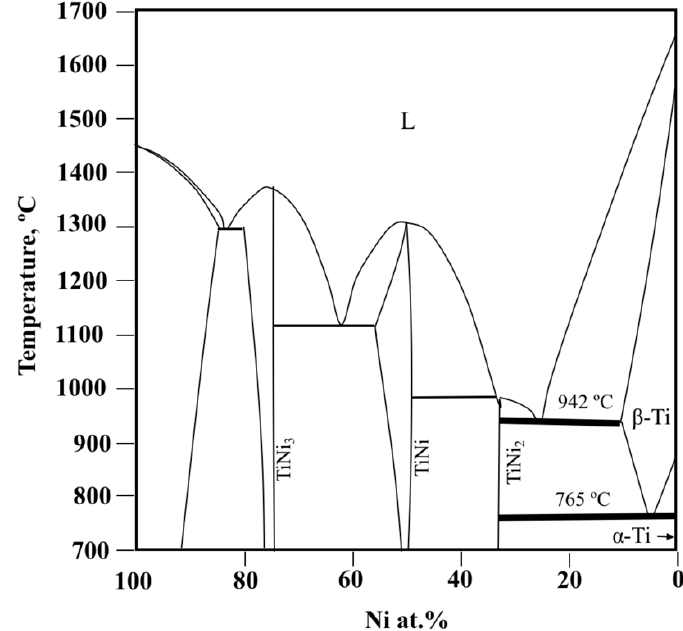
Figure 8. Ti-Ni phase diagram, where the invariant reactions on the Ti-rich zone are highlighted, adapted from [21], with permission of Elsevier, 2013.